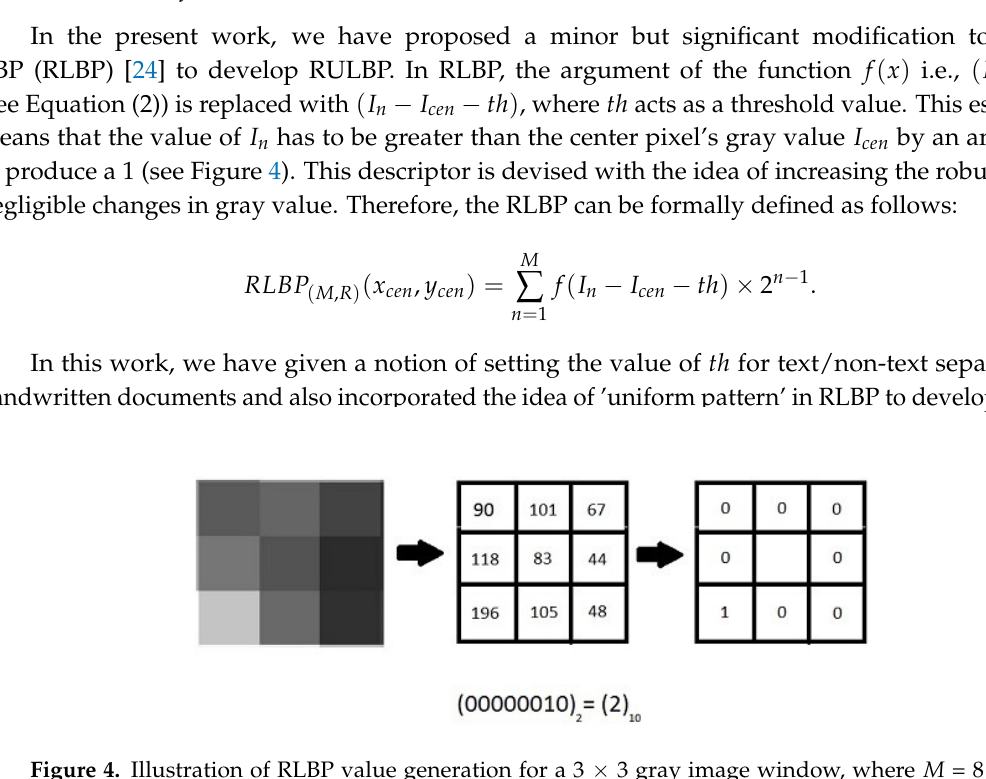
Figure 4. Illustration of RLBP value generation for a 3 × 3 gray image window, where M = 8 and Radius = 1. Here, the value of th =